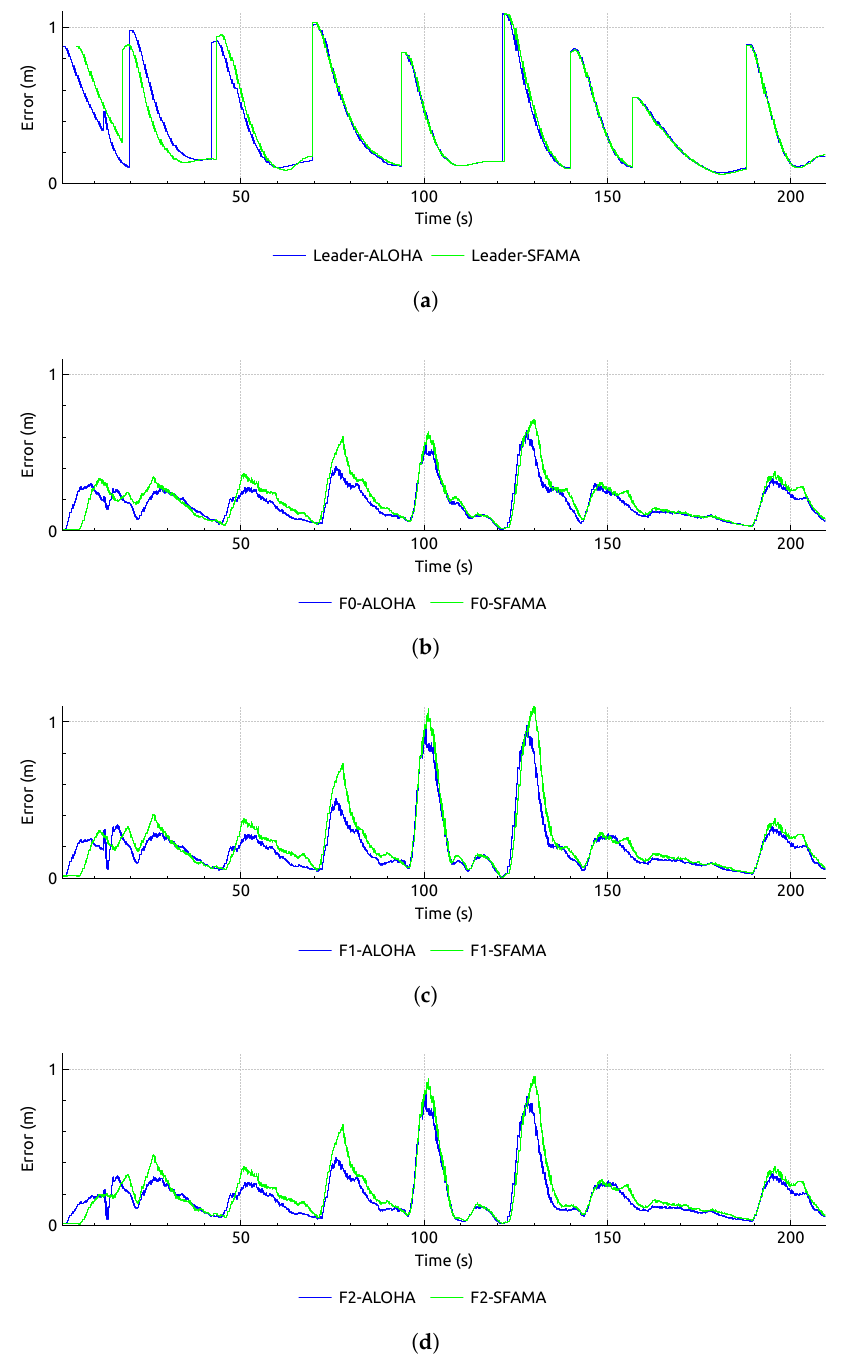
Figure 9. Waypoint distance error for each AUV for the CS-ALOHA and S-FAMA MAC protocols. ( a ) Distance between commanded position and actual position of the leader. Distance between actual position and expected position based on leader’s for: ( b ) the AUV on the left of the leader; ( c ) the AUV placed back and left; and ( d ) the AUV placed behind the